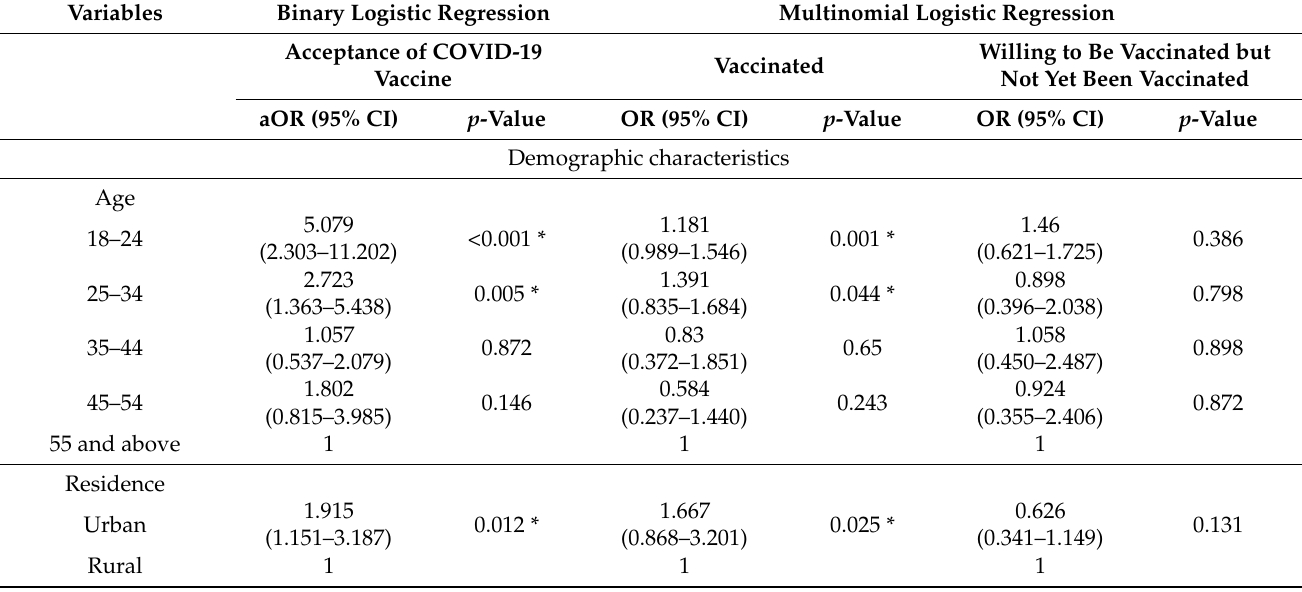
Table 3. Outcomes of logistic regression (ref: Vaccine